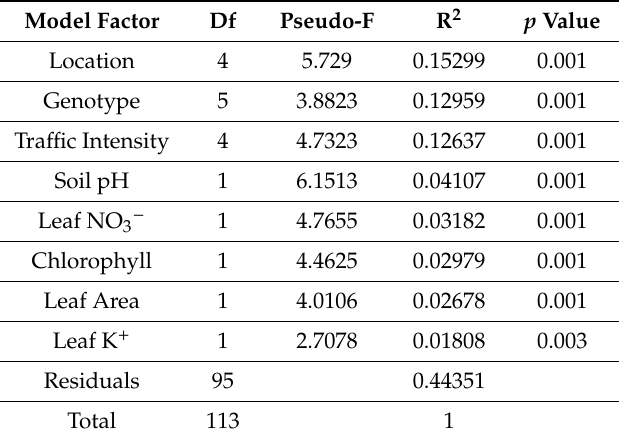
Table 3. Drivers of endophytic communities of Kudzu based on PerMANOVA analysis based on the Bray-Curtis dissimilarity values. Factors are listed in the order of descending R 2 values.